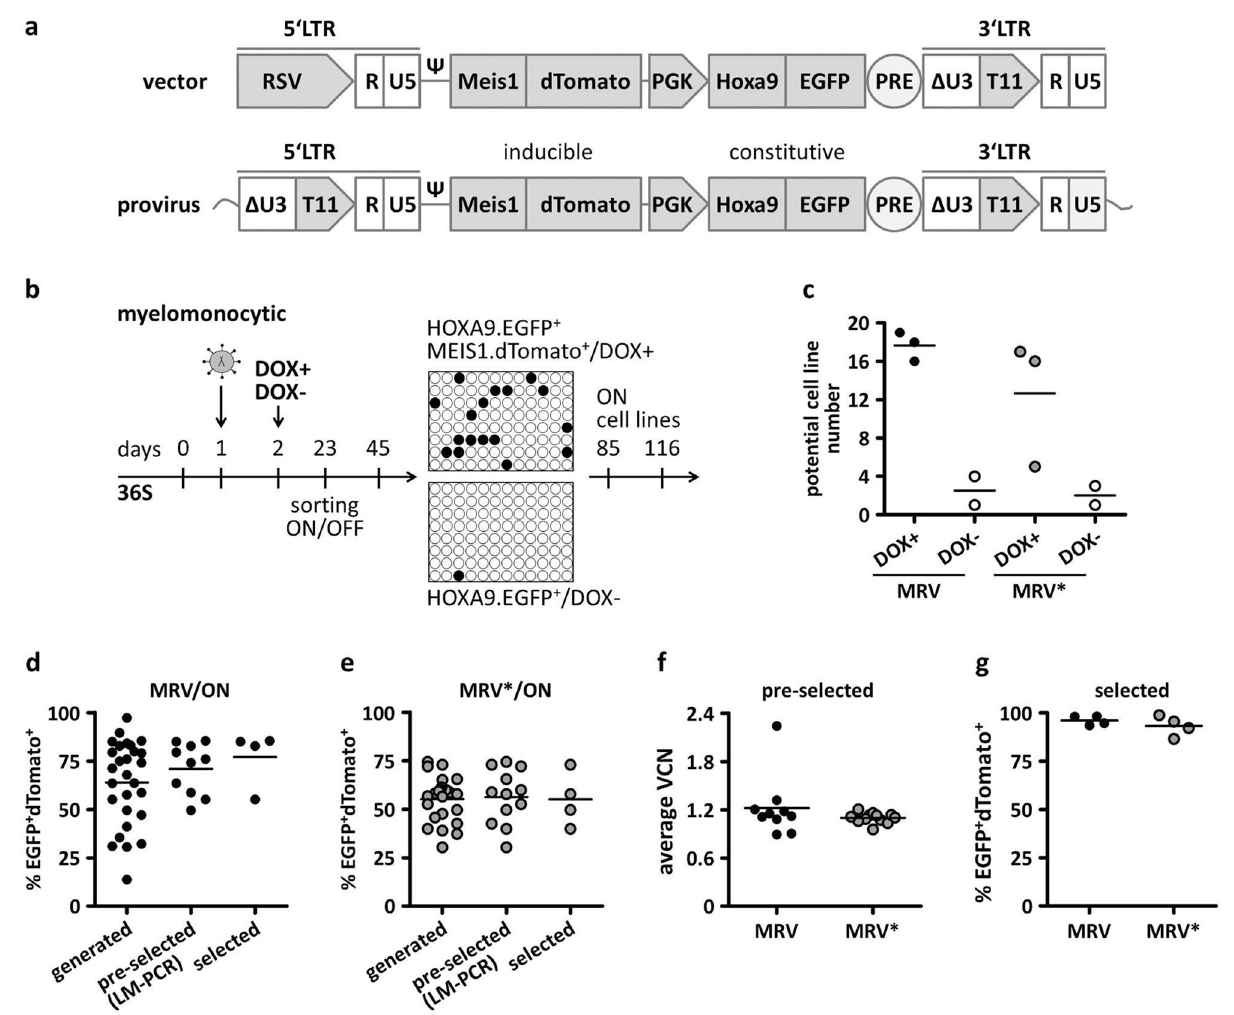
Figure 1. Generation of conditionally immortalised myeloid progenitor cell lines co-expressing Hoxa9 and Meis1 in the presence of doxycycline. ( a ) Schematic representation of multimodal retroviral vector and integrated provirus to enable constitutive Hoxa9 . EGFP and inducible Meis1 . dTomato gene co-expression. RSV, Rous sarcoma virus promoter; Δ, SIN configuration with partially deleted U3 of the 3 ′ long terminal repeat (LTR); ψ, packaging signal; PRE, post-transcriptional regulatory element; EGFP, dTomato, fluorescent proteins. ( b ) Experimental design. Murine Rosa26rtTA lineage negative cells were transduced on day 1 under myelomonocytic conditions (36S) without doxycycline (DOX). On the next day, cells were split into DOX untreated (DOX-, OFF) and DOX treated cultures, which were supplemented with 1 µg/mL DOX (DOX+ , ON). HOXA9.EGFP + /MEIS1.dTomato + double-positive cells (DOX+) and HOXA9.EGFP + (DOX-) were sorted on days 13–23 after transduction followed by a limiting dilution assay to select stable H9M-ciMPs. ( c ) The number of potential cell lines for DOX+ and DOX- conditions (~ day 45 after transduction). The experiment was performed independently for multimodal retroviral vectors with (MRV) or without (MRV*) LM-PCR linker in three biological replicates for DOX+ and two biological replicates for DOX- conditions (one biological replicate / one 96-well plate). ( d-e ) The number of generated, pre-selected for LM-PCR analysis and selected cell lines for MRV and MRV* vectors under DOX supplementation. ( f ) Average vector copy number (VCN) determined for pre-selected ( n = 10 for MRV, n = 12 for MRV*) H9M-ciMPs. ( g ) Gene expression levels of EGFP + dTomato + double-positive cells in selected ( n = 8) H9M-ciMPs after cryopreservation (pre-cultured ~ 3 months in 36S conditions before cryopreservation). Horizontal lines represent the mean values. Each data point represents the result of an individual cell line. LM-PCR, ligation-mediated PCR. H9M-ciMPs, conditionally immortalised myeloid progenitor cell lines engineered to co-express Hoxa9 and Meis1 . ( d – g ) generated in Prism 5 (GraphPad software, San Diego,